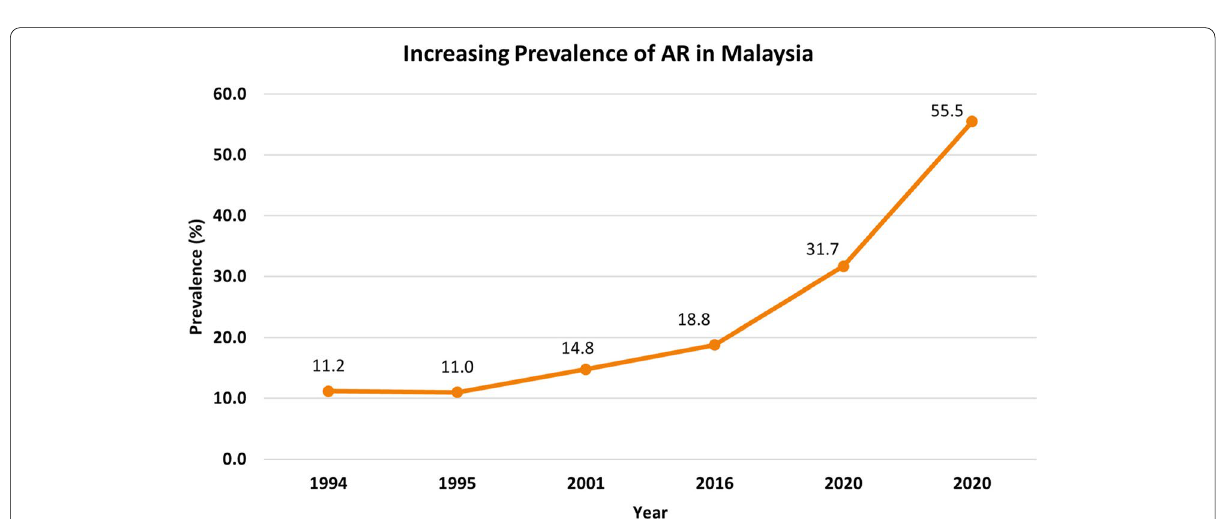
Fig. 2 Increasing prevalence of allergic rhinitis among secondary school children in